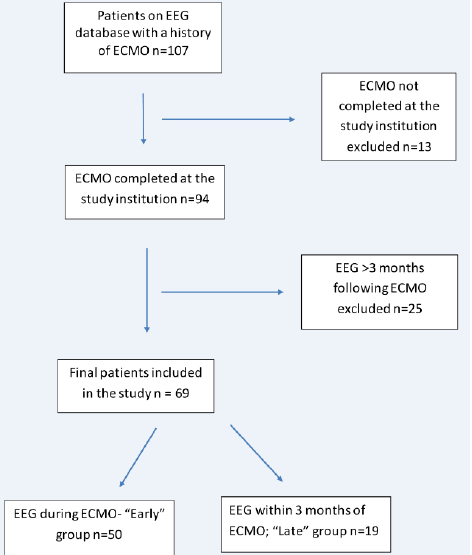
Figure 1. Schematic outlining inclusion and exclusion of patients in the study. Extracorporeal Membrane Oxygenation (ECMO), Electroencephalogram (EEG).